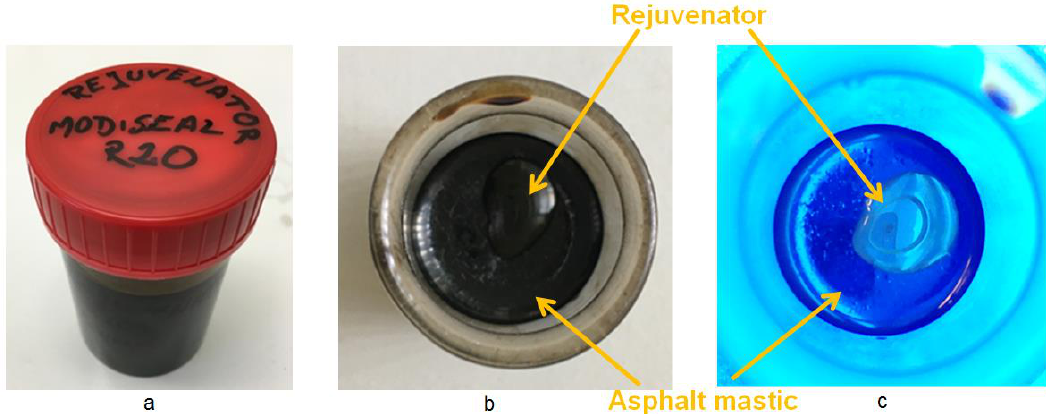
Figure 2. Rejuvenator R20: ( a ) normal appearance; ( b ) on asphalt mastic under visible light and ( c ) on asphalt mastic under UV light.